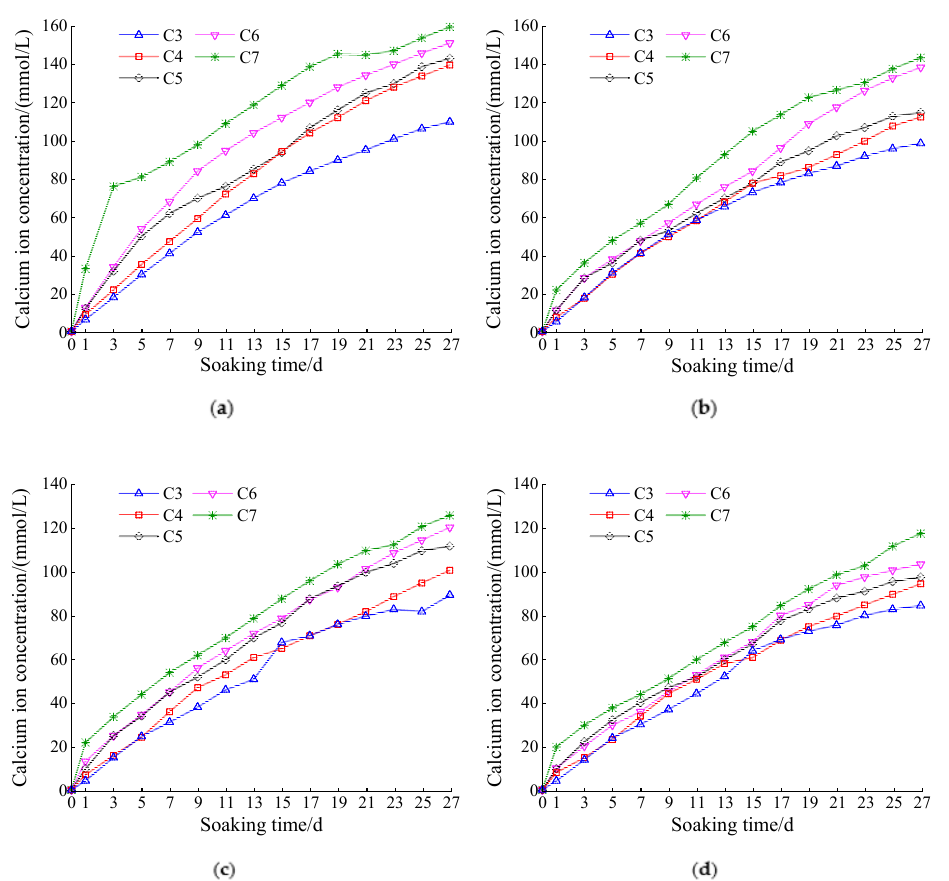
Figure 4. Calcium ion concentration curve at different cement dosages: ( a ) cement:fly ash = 1:0; ( b ) cement:fly ash = 1:0.1; ( c ) cement:fly ash = 1:0.2; ( d ) cement:fly ash = 1:0.3.